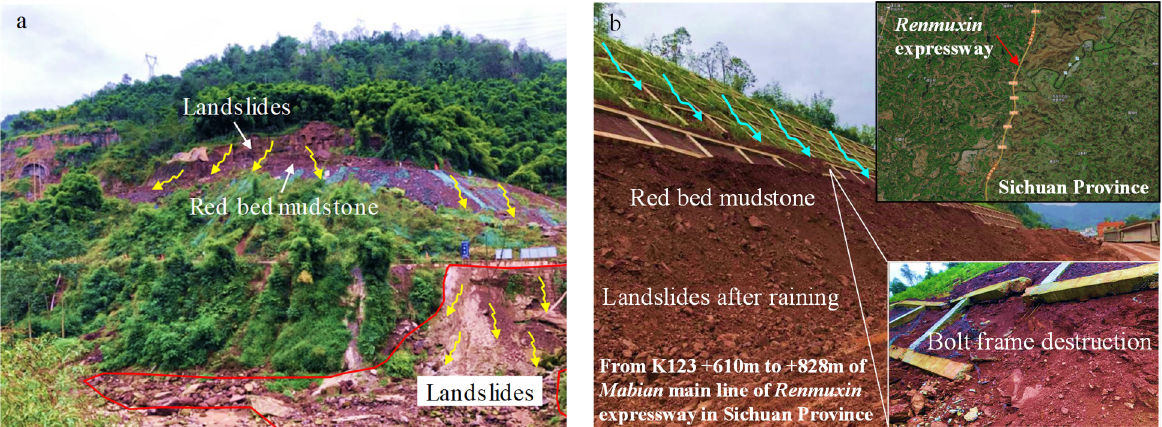
Figure 1. Characteristics of geologic landslide and engineering catastrophes of red-bed soft rocks in Southwest China. ( a ) Red-bed landslide after rainfall. ( b ) Side slope support failure of the Renmuxin highway.